Question: Generate an informative caption for the figure above.
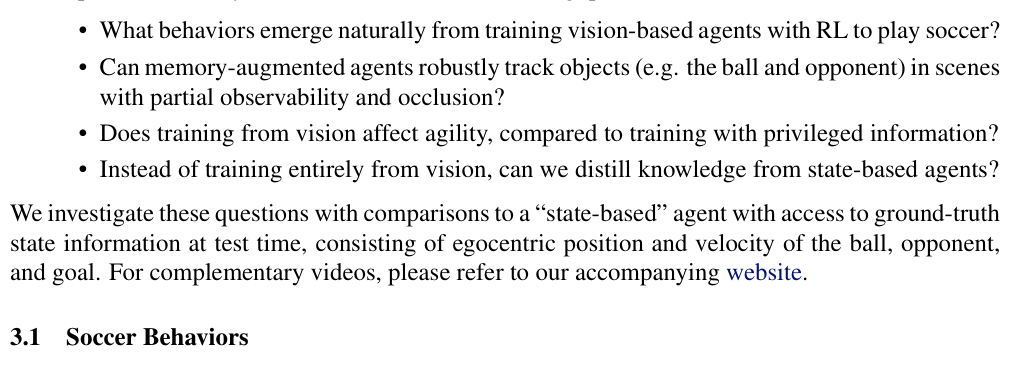
Answer: highlights behaviors that emerge while training agents in simulation: searching for the ball, scrambling, and blocking a shot. These are complex, long-horizon, multi-agent behaviors that rely on active vision and are difficult to manually script. Interestingly, such behaviors emerge naturally from the soccer task reward, and without the need for explicit reward terms for, say, finding the ball.